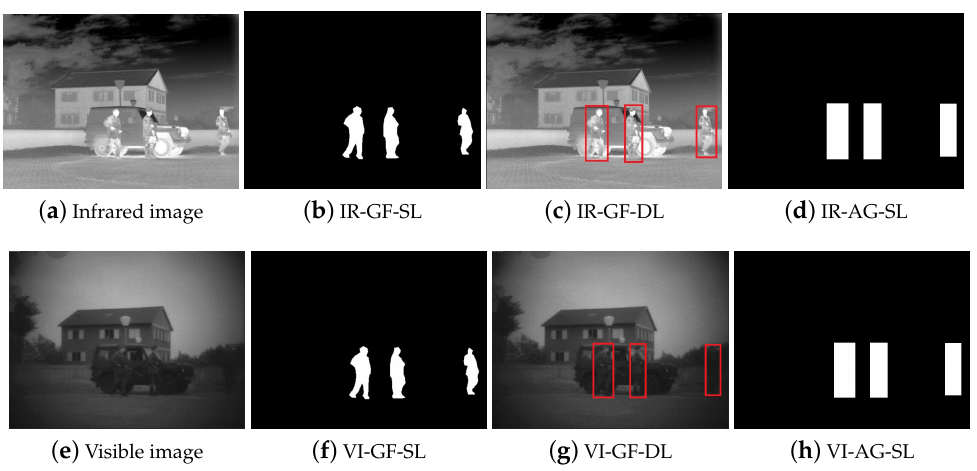
Figure 3. ( a ) The infrared image; ( b ) the ground-truth segmentation label of ( a ), abbreviated IR-GF-SL; ( c ) the ground-truth detection label of ( a ), abbreviated IR-GF-DL; ( d ) the automatically generated segmentation label based on bounding boxes in ( c ), abbreviated IR-AG-SL. ( e ) The visible image; ( f ) the ground-truth segmentation label of ( e ), abbreviated VI-GF-SL; ( g ) the ground-truth detection label of ( e ), abbreviated VI-GF-DL; ( h ) the automatically generated segmentation label based on bounding boxes in ( g ), abbreviated